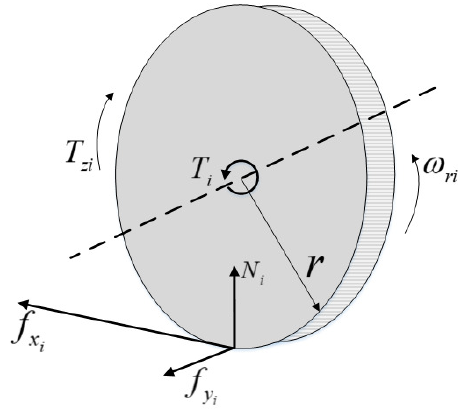
Figure 2. Wheel rotational motion.